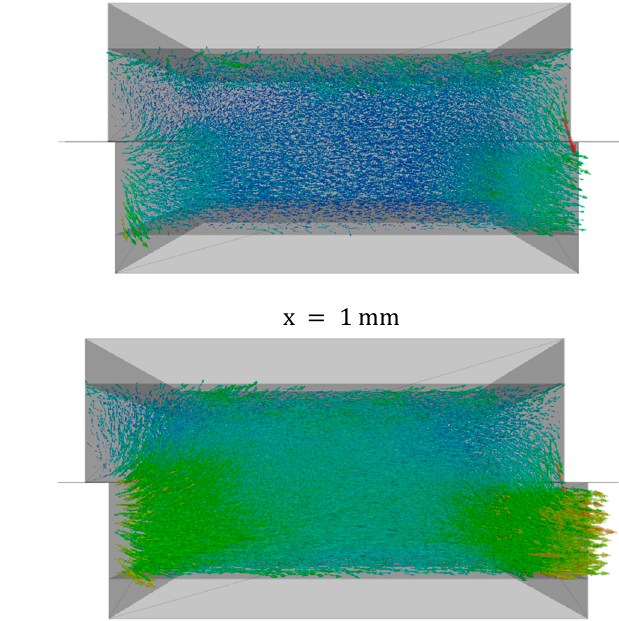
Figure 6. Distribution of contact forces (projection of all contact forces) drawn at the same scale for sample sheared under σ n = 160 kPa to different distances (x = 0 − 8mm).